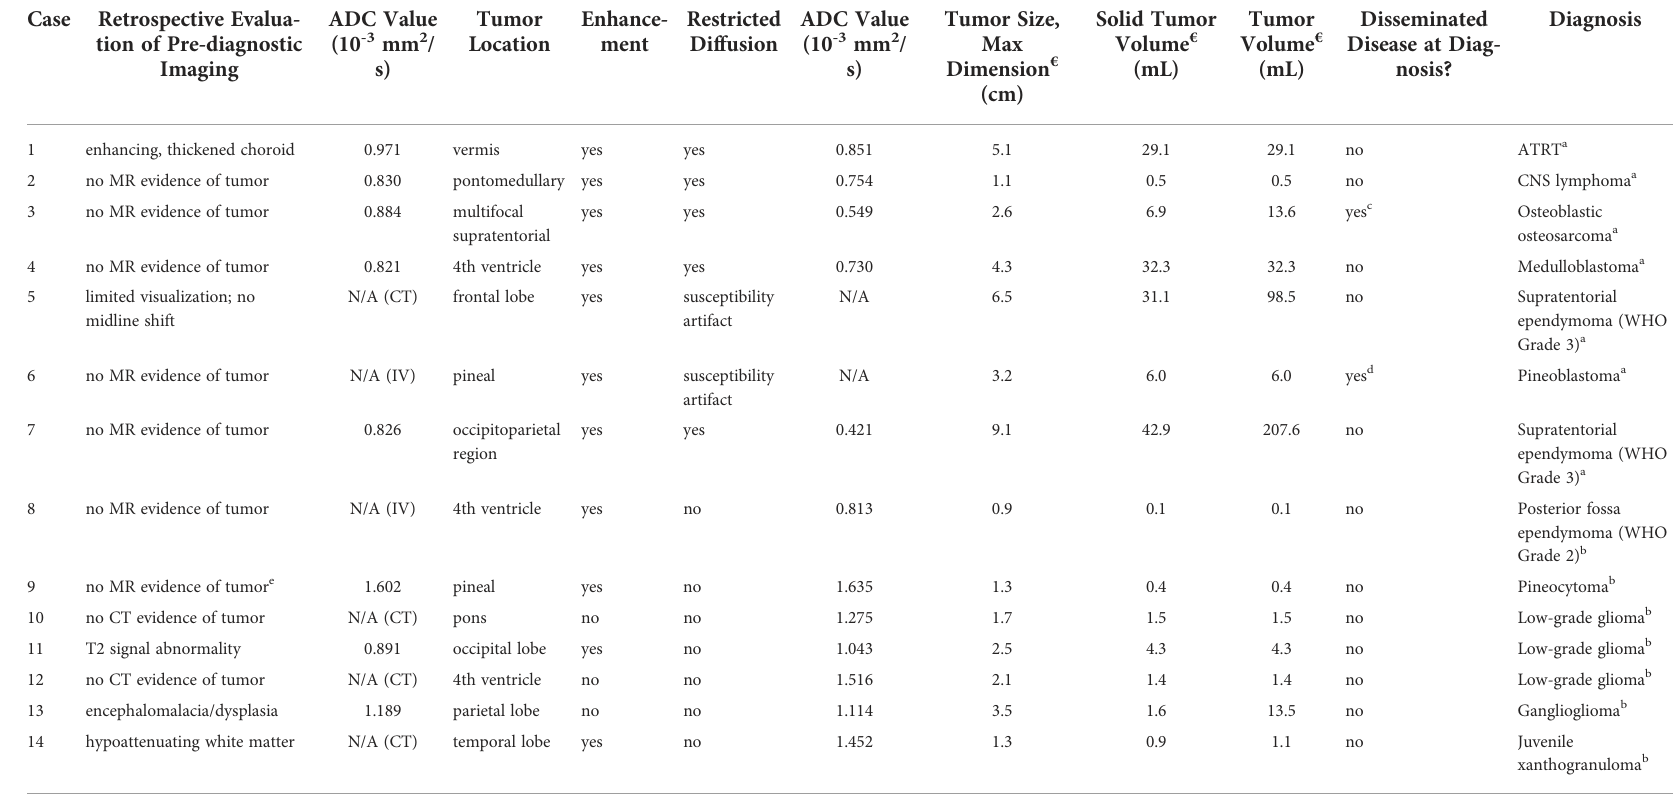
TABLE 2 Pre-diagnostic and Diagnostic Neuroimaging